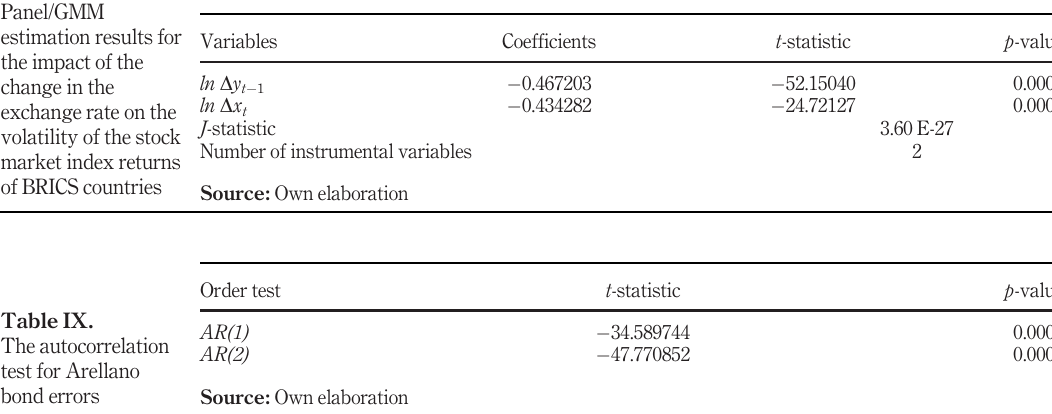
test for Arellano bond